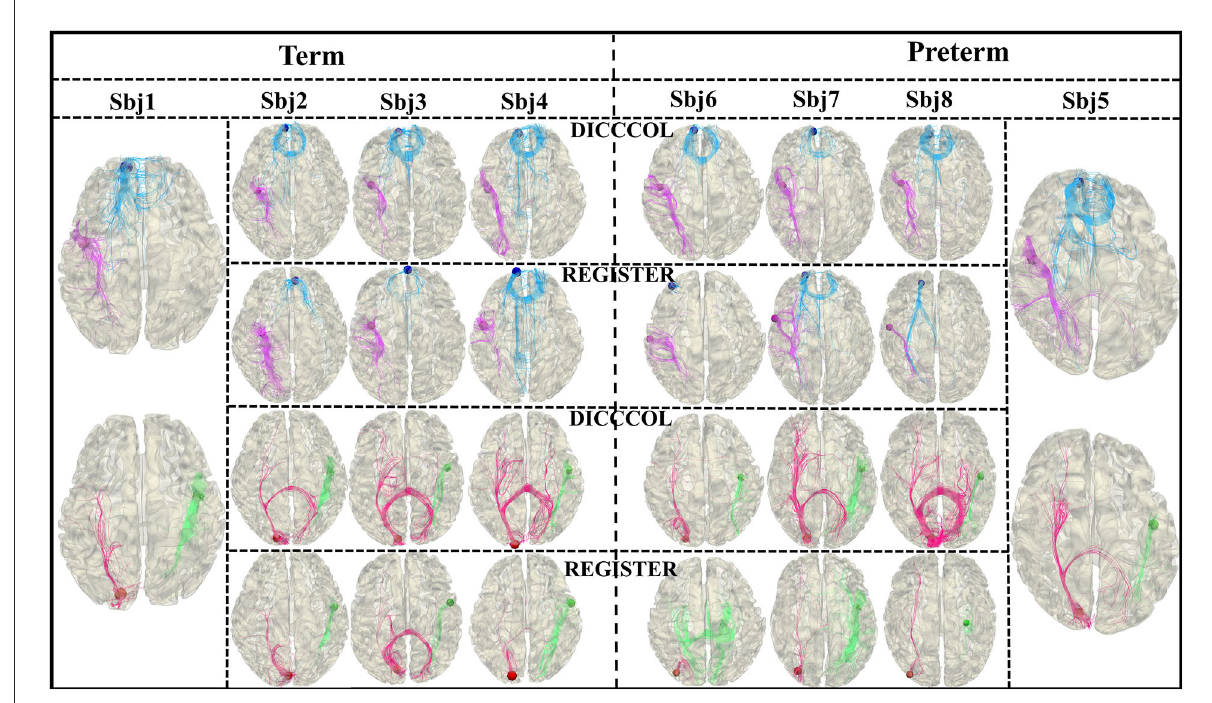
FIGURE7 Fiber shapes of DICCCOL landmarks and registered